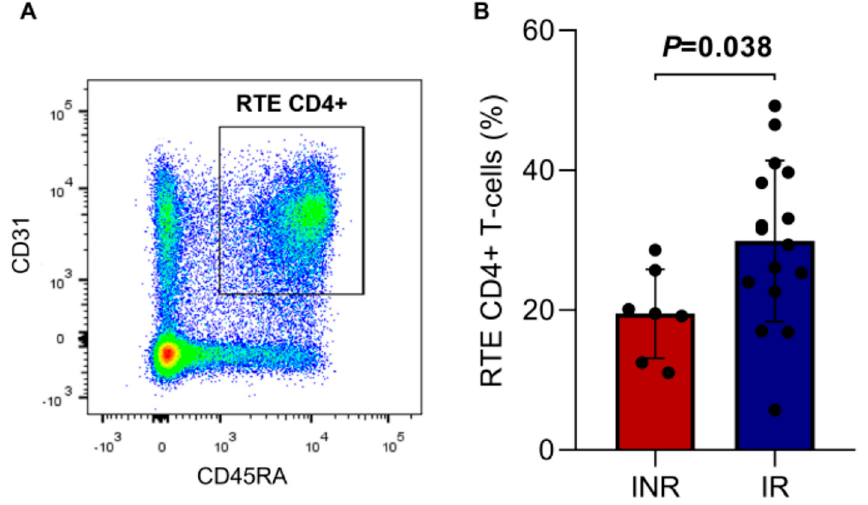
Figure 3. (A) Representative dot plot showing the gating strategy for RTE CD4+ T cells (CD4+/CD45RA+CD31+). (B) Percentage of RTE CD4+ T cells in the INR and IR groups. Means, standard deviation, and p -value (according to the t-test) are shown. INR—immunological non-responders. IR—immunological responders. RTE—recent thymic emigrants.